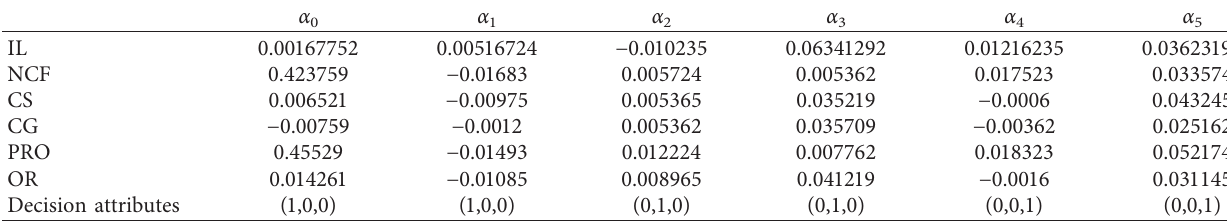
Table 2: Financing decision form under the operation risks of green enterprises.